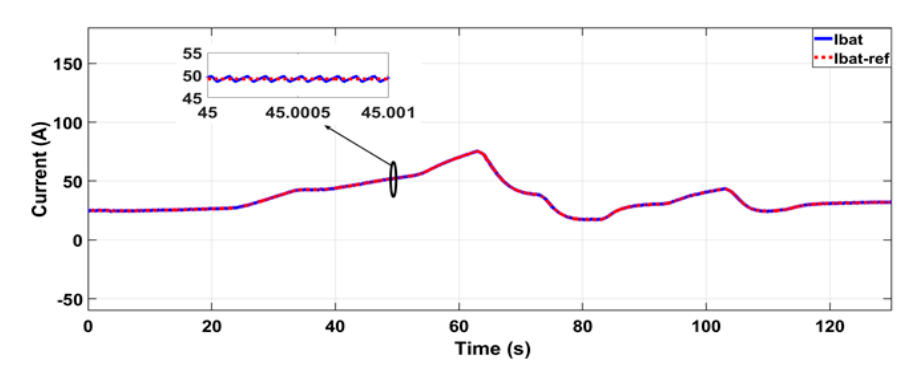
Figure 10. 𝒗 𝒅𝒄 voltage and reference.